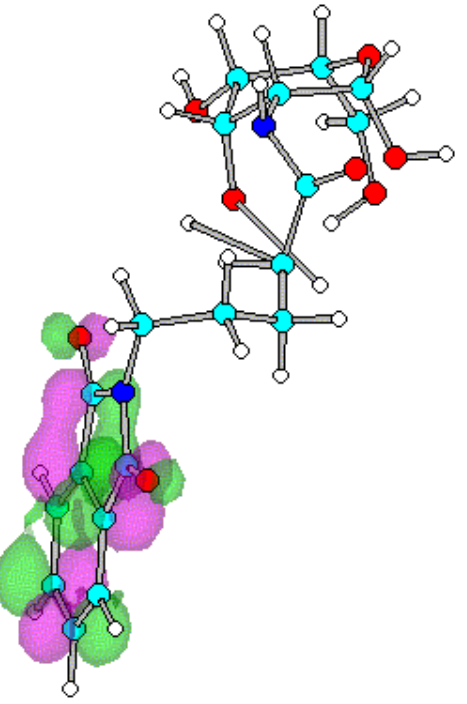
Figure 6. Optimized geometry and spatial distribution of LUMO for N-acyl-AG